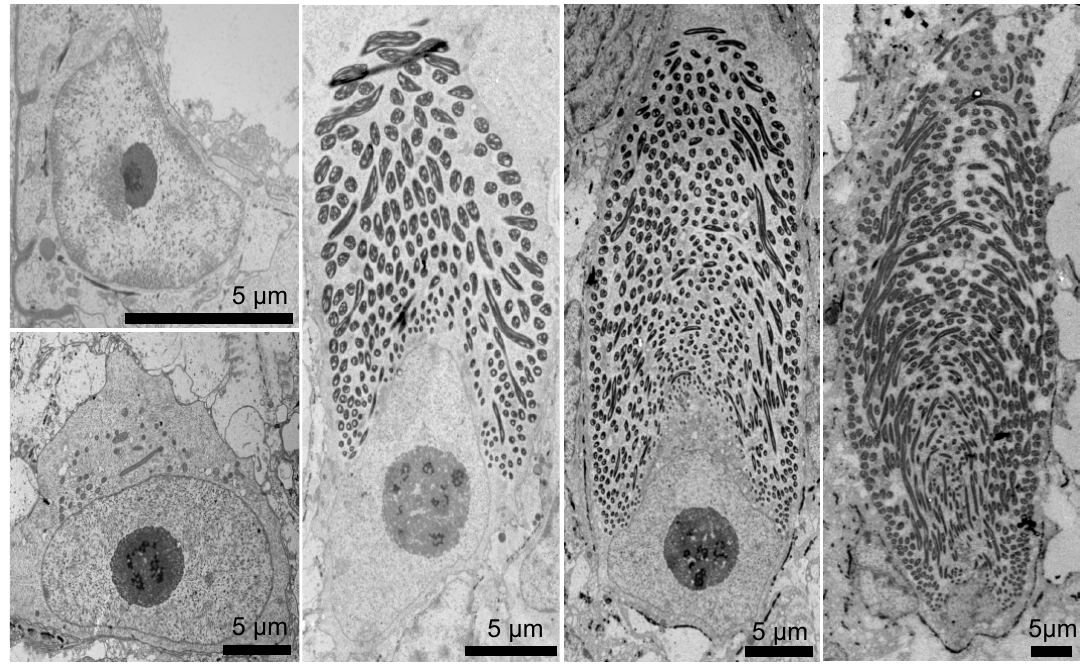
Figure 3. Transmission electron micrographs (TEM) of gland thread cell (GTC) development. Development series of hagfish GTCs reveals dramatic changes in nuclear size and shape as the cell matures. Immature GTCs, which lack a slime thread, can be identified by their prominent nuclei and nucleoli, while most of the space within a fully mature GTC is occupied by the thread skein. As the GTC develops, the nucleus becomes more spindle-like, eventually receding to the basal end of the cell in mature cells. Scale bars are 5 μ m [24].